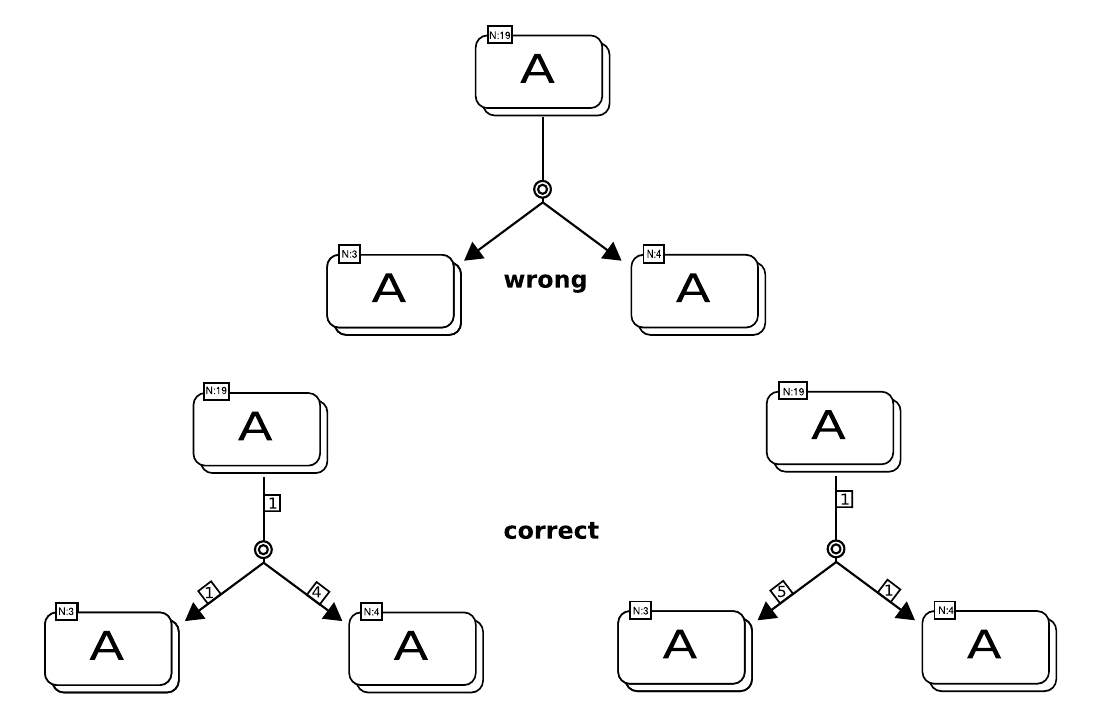
Figure 2.43: Cardinality for production arcs.